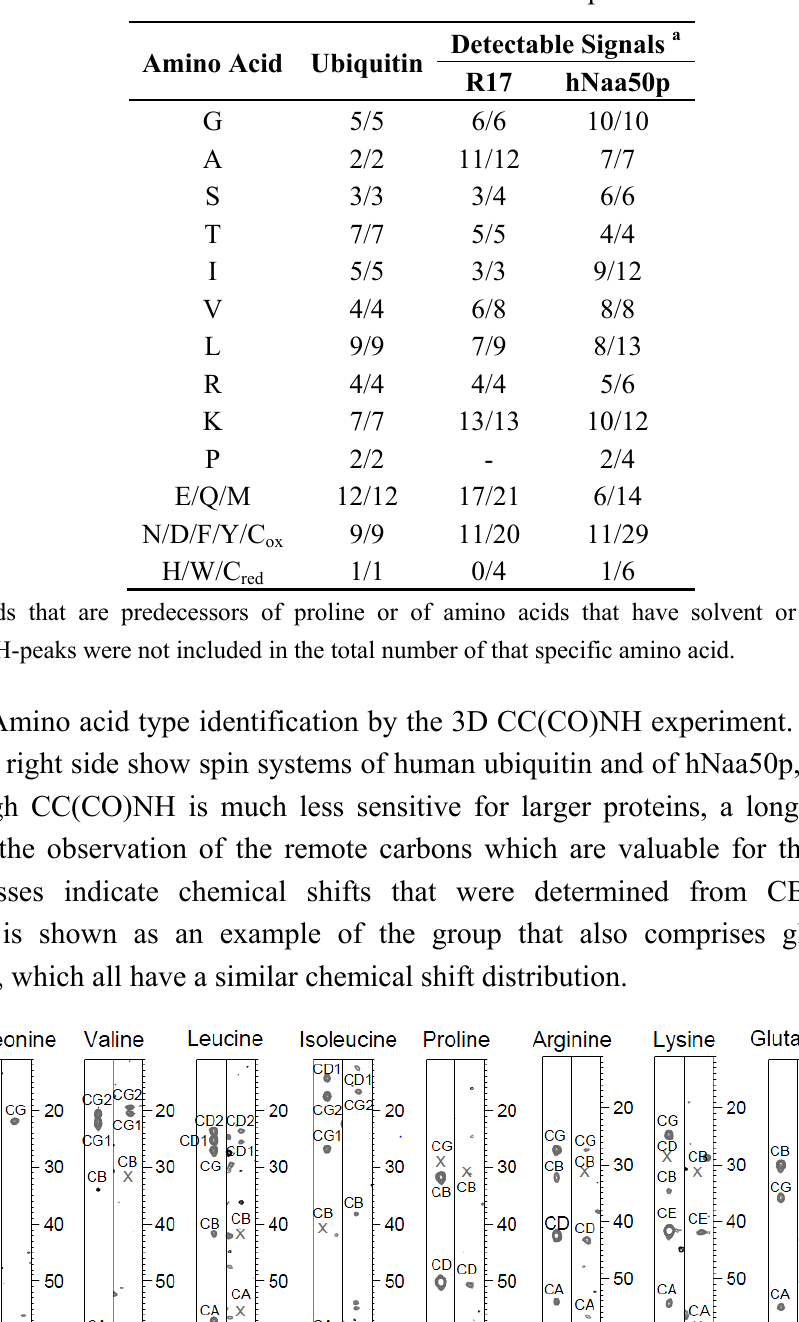
Table 1. Amino acid type specificity of 3D CC(CO)NH using long isotropic mixing times of 27 (ubiquitin) or 28 ms. The table shows how many of the total number of an amino acid type could be identified in one small and two medium-sized proteins.